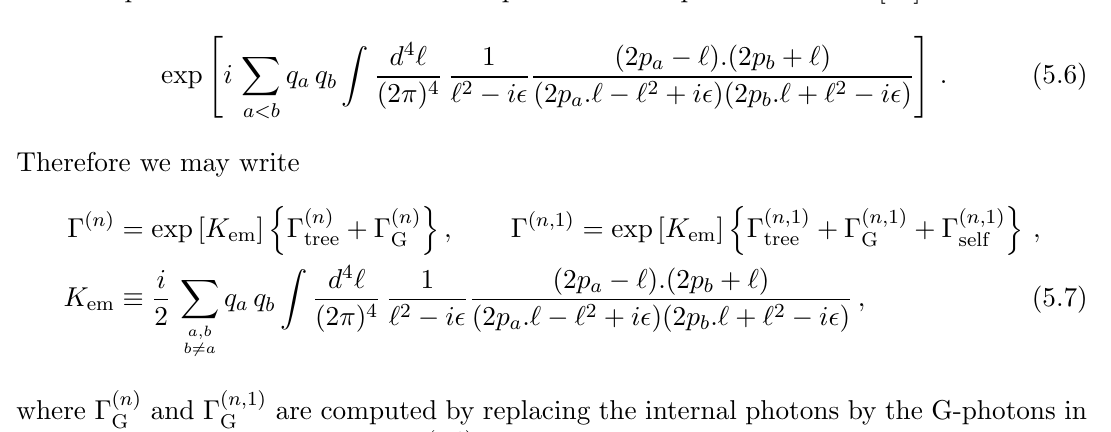
Figure 4 . Diagrammatic representations of (5.4) and (5.5). The arrow on the photon line represents that the polarization of the photon is taken to be equal to the momentum entering the vertex. The circle denotes a simple vertex (cid:0) q c with the polarization of the incoming photon stripped o(cid:11). of the K-photons to either (cid:0) ( n ) or (cid:0) ( n; 1) produces an exponential factor